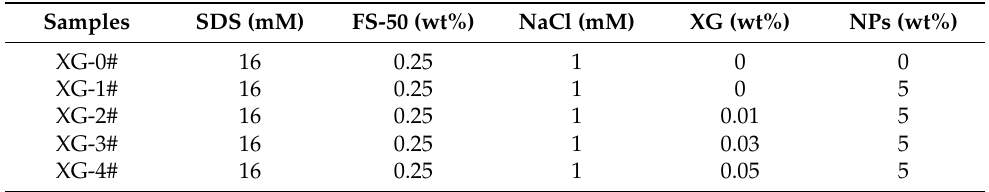
Table 1. Components of foam dispersions.